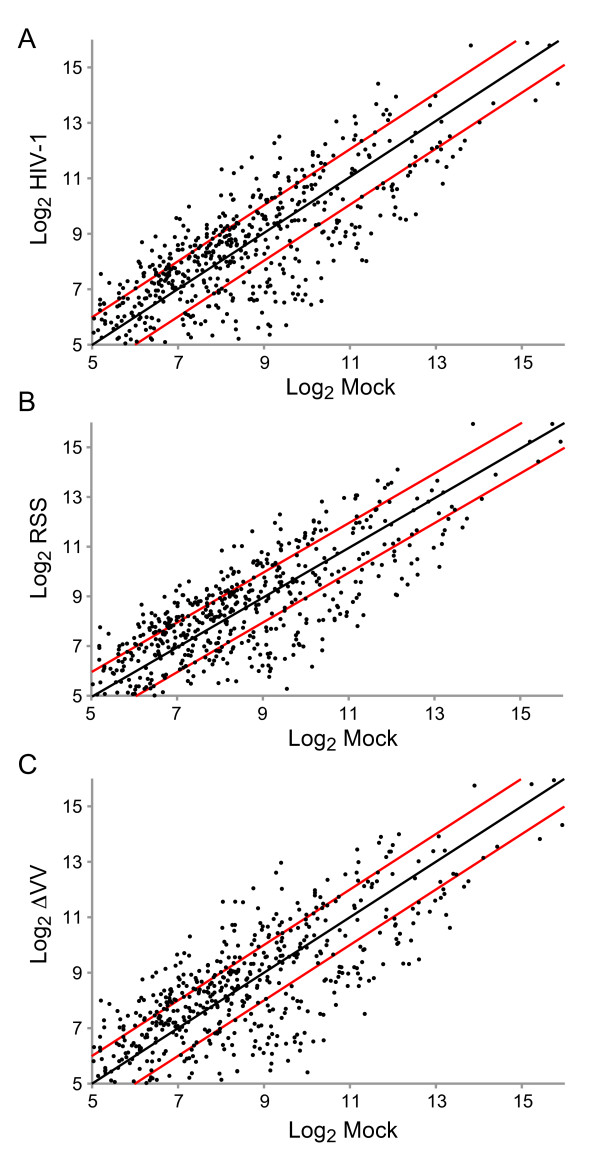
Host miRNA expression is changed by infection with HIV-1, Vif/Vpr -deficient or RSS-deficient viral strains. Scatterplot analysis of miRNA mature and precursor probes expression changes observed on microarrays hybridized with RNA of human CEMx174 lymphocytes unexposed to virus or infected with HIV-1, or ΔVV, or RSS. Each data point represents one unique probe sequence. The black line at x = y illustrates baseline of no change. The red lines illustrate change by a factor of 2. Axes are truncated at log2 = 5 to eliminate measurement uncertainty at lower signal intensities. Log2 expression values of human miRNA probes in the mock sample are shown on the x-axis and the corresponding values for the HIV-1 sample are shown on the y-axis. (a) HIV-1 versus mock infection; (b) RSS versus mock infection; (c) ΔVV versus mock infection.